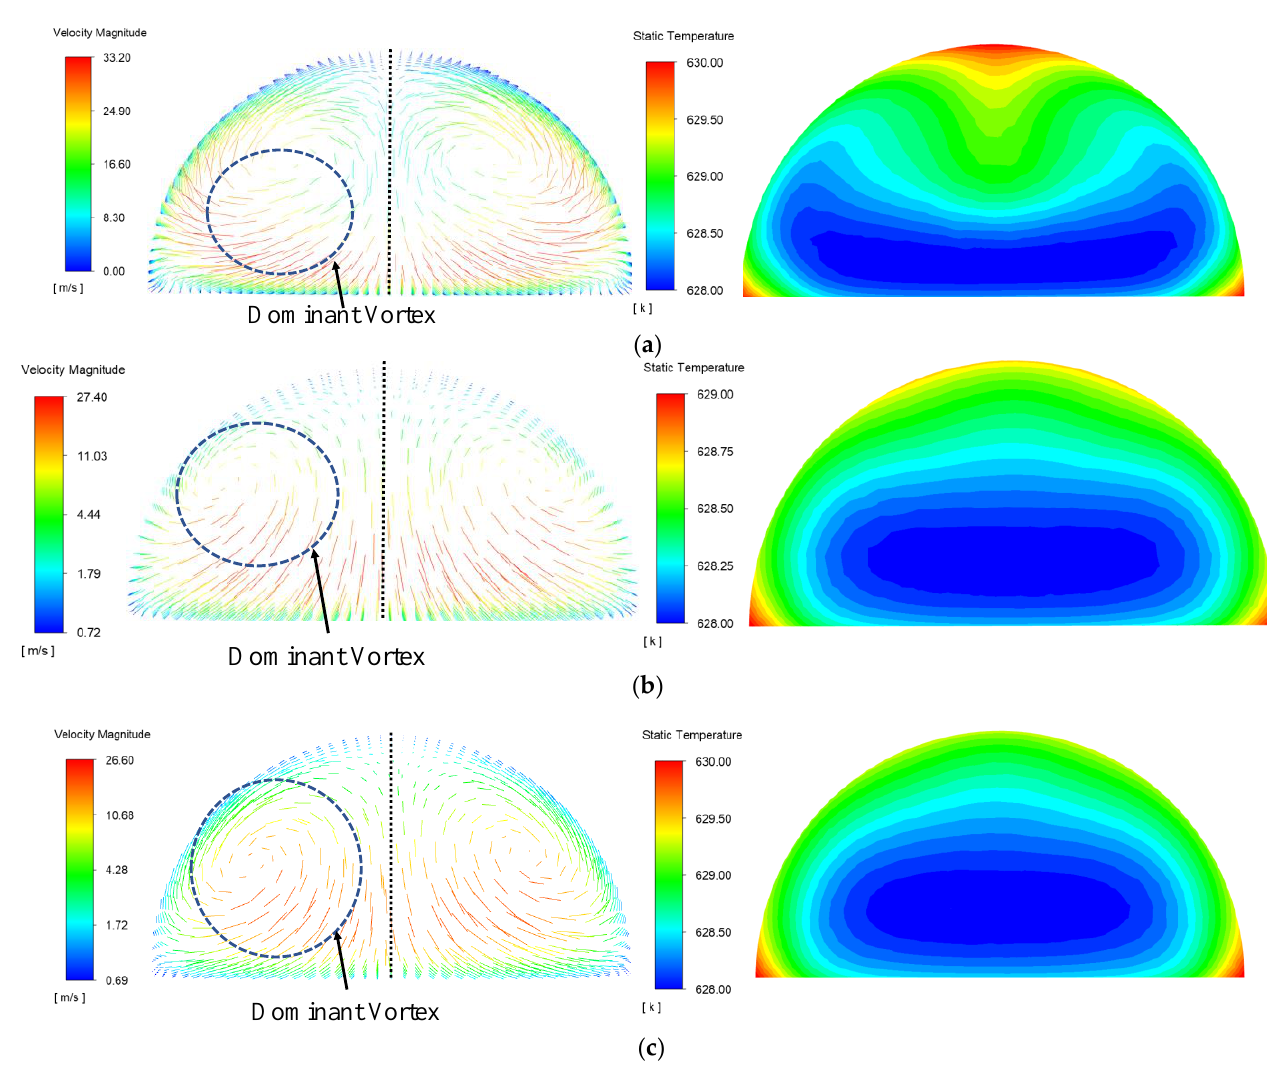
Dominant Vortex